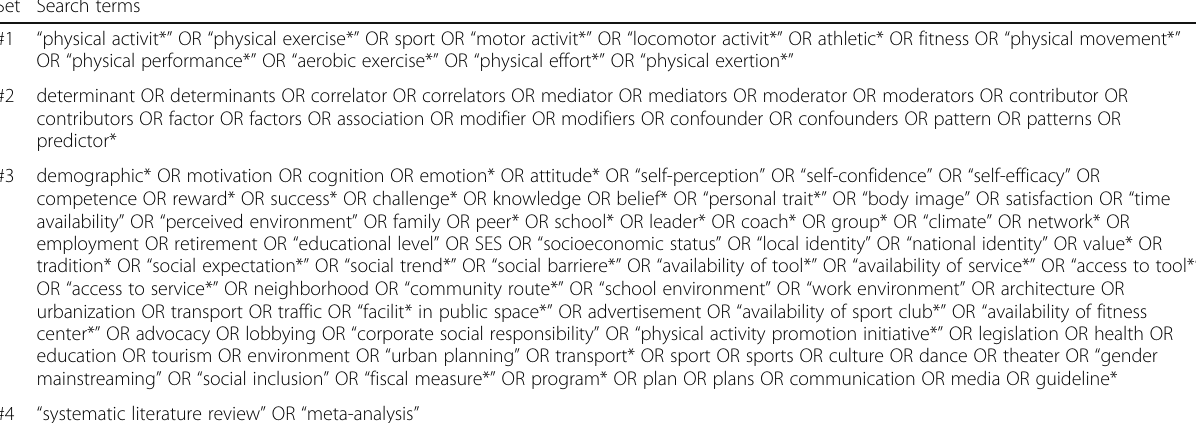
Table 1 Search strategy: key words used for the literature research Set Search terms